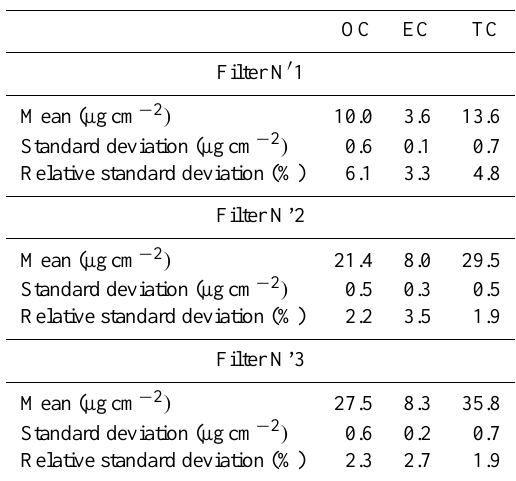
Table 2. Mean, standard deviation (SD), relative standard deviation (RSD) obtained for the 18 punches made on filters N 0 1, N 0 2 and N 0 3 to evaluate the filter sample